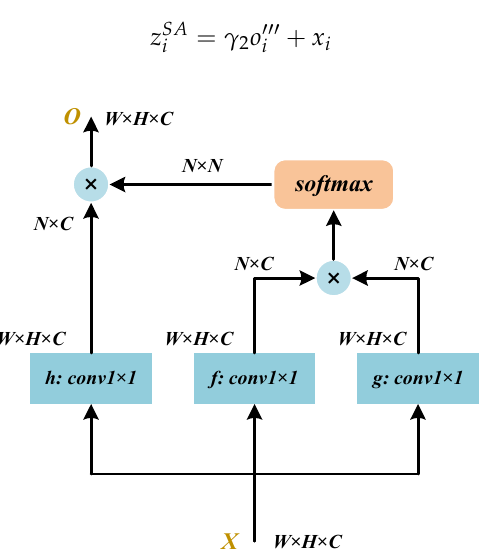
Figure 4. Diagram of the employed self-attention